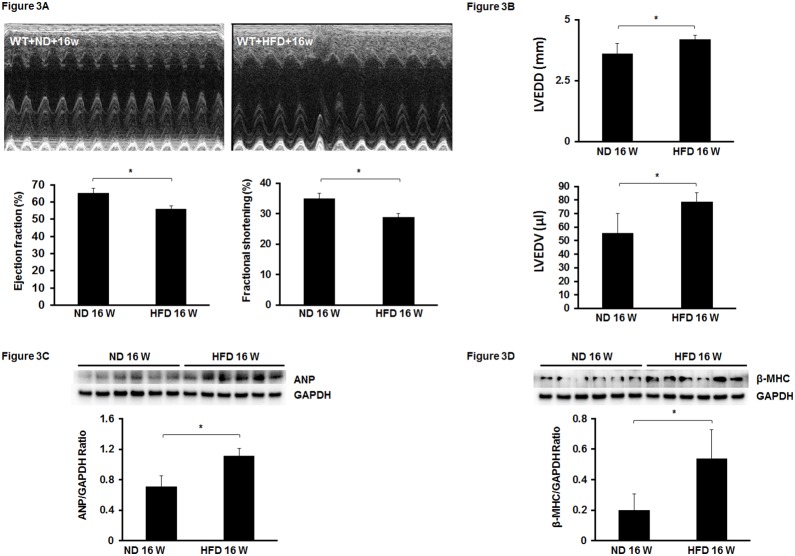
Feeding with HFD for 16 weeks leads to cardiac dysfunction in mice.(A) Upper panel: Representative images of M mode of echocardiography. Low panel: Feeding mice with HFD for 16 weeks significantly impaired cardiac performance indicated by decreases in EF and FS levels in HFD mice compared to ND mice (n = 5–7 mice, *p<0.05). (B) Left ventricular end diastolic diameter (LVEDD) and left ventricular end diastolic volume (LVEDV) were significantly elevated in HFD mice compared to ND mice at 16 weeks (n = 5–7 mice, *p<0.05). (C and D) Expression of cardiac hypertrophic markers ANP and β-MHC in HFD and ND mice. The levels of ANP and β-MHC were significantly higher in the hearts of HFD mice than that of ND mice at 16 weeks (n = 6 mice, *p<0.05).